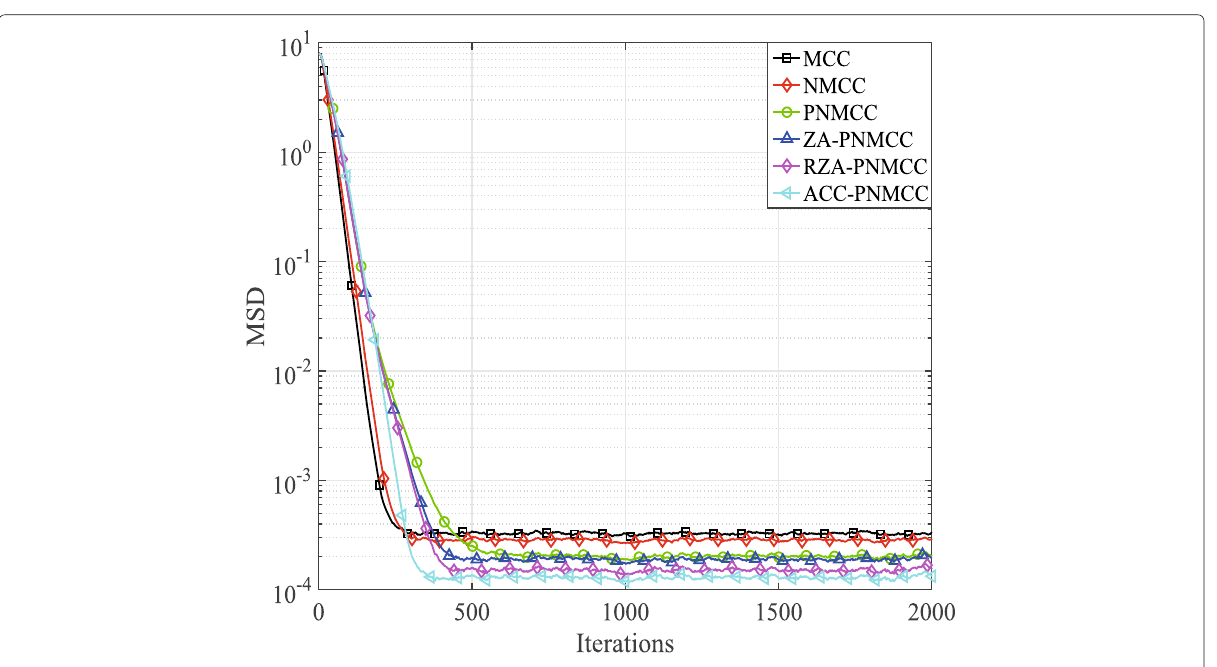
Fig. 7 The MSD performance of the proposed ACC-PNMCC algorithm with K =